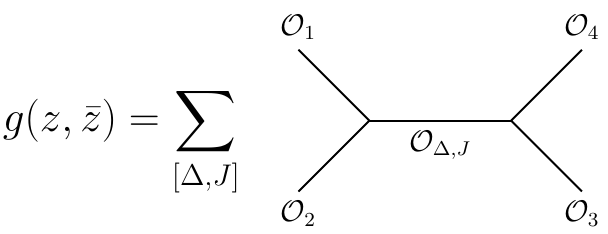
Figure 2 . A diagrammatic description of the conformal block decomposition. A local primary operators O (cid:1) ;J appears in the intermediate